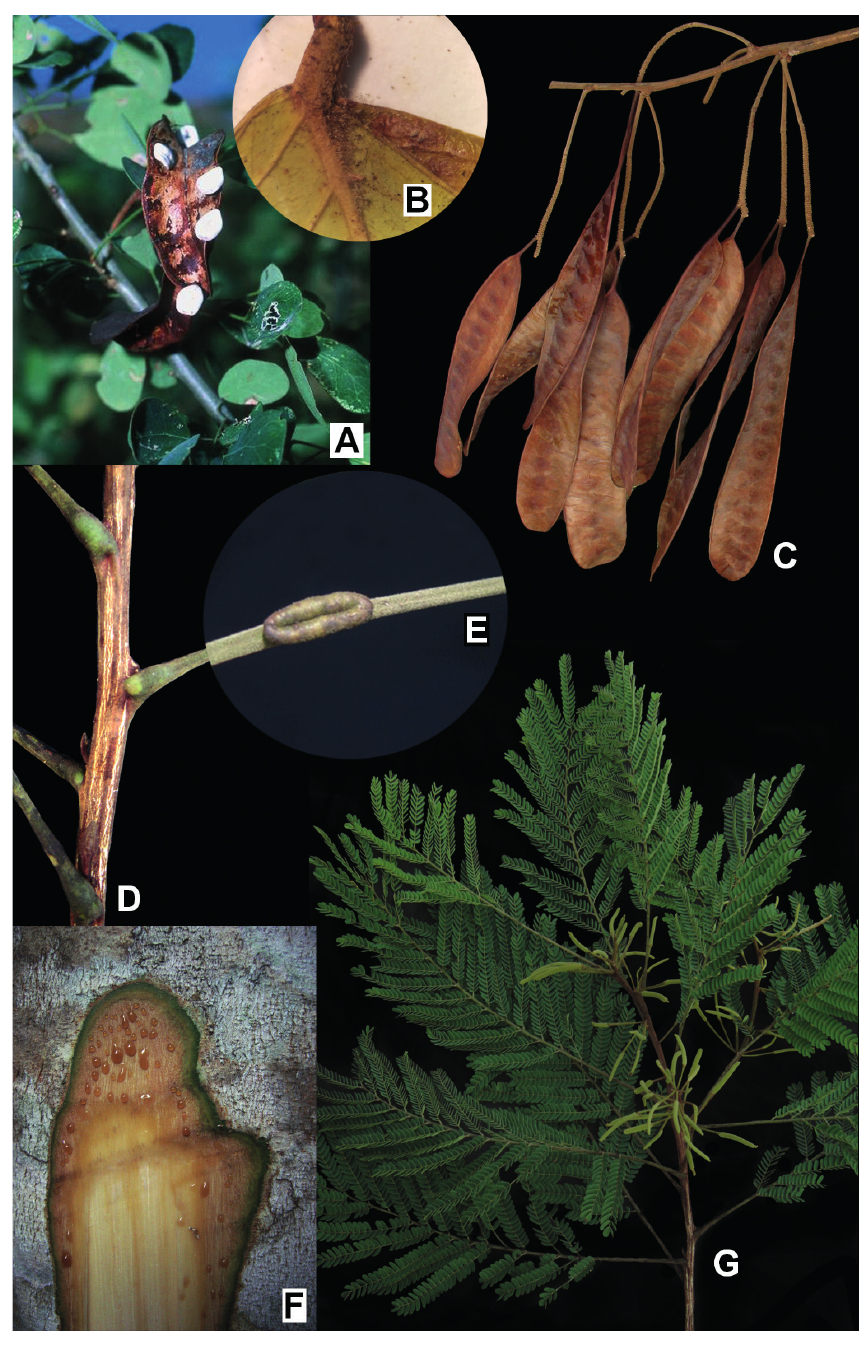
Figure 3. A, B Microlobius foetidus : A fruiting branch with white seeds exposed B detail of a leaflet showing the tuft of trichomes at the base of the midrib C–G Naiadendron duckeanum : C fruits D detail of the striated branch E detail of petiolar nectary (upper view, magnified) F bark slash showing reddish exu- date G flowering branch. Photos: A Donovan Bailey B Alexandre Gibau de Lima C–G Marcelo